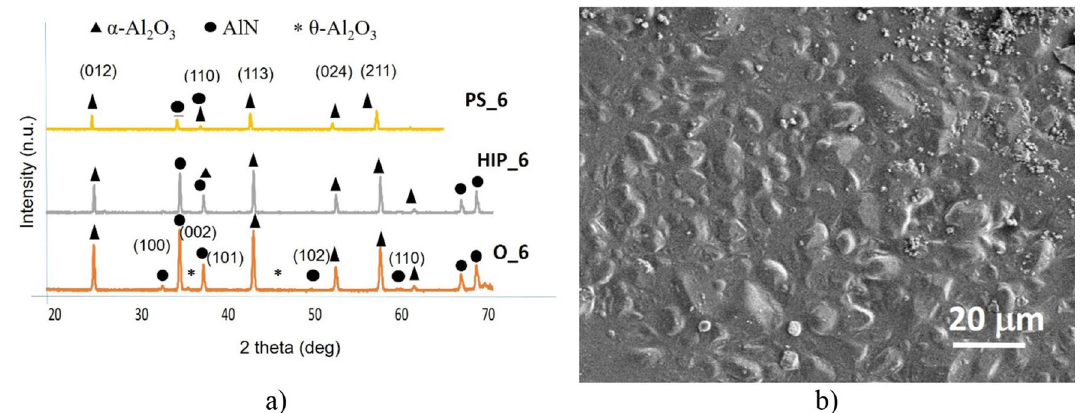
Figure 6. Investigation of oxidized AlN at 6 h. ( a ) XRD plots of oxidized AlN powder (O_6), HIP sintered (HIP_6) and sintered at H